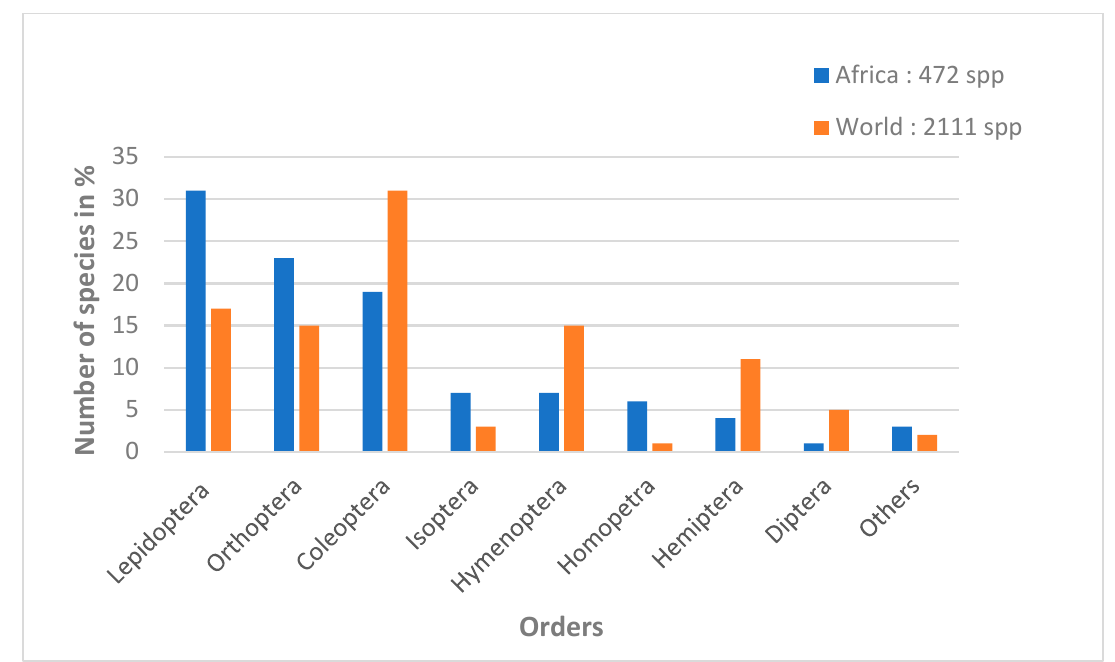
Figure 1. Percentage of insects consumed by order in Sub-Saharan Africa and worldwide (adapted from Mariod [28]).